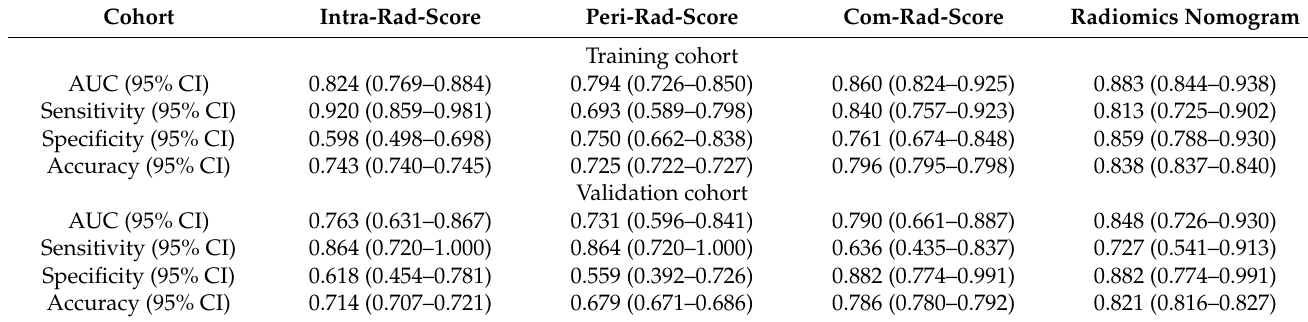
Figure 4. ROC curves of the three rad-scores in each cohort. ( a ) ROC curves of the three rad-scores in the training cohort. ( b ) ROC curves of the three rad-scores in the validation cohort. Table 3. Discriminative performances of three rad-scores and radiomics nomogram for predicting HER-2 2+ status in the training and validation cohorts.